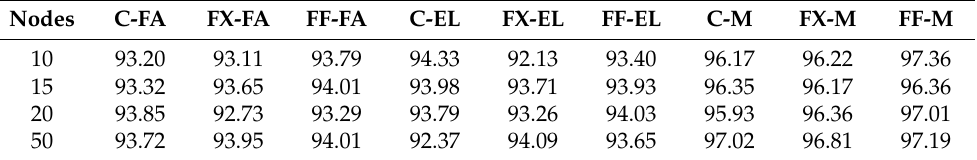
Table 3. Evaluating accuracy in various methods comparison. The C, FX, and FF at the former positions represent the dataset of CWRU, FSTB Direction X, and FSTB Fusion. The FA, EL, and M at the latter positions represent the method of FedAvg, EL Method, and